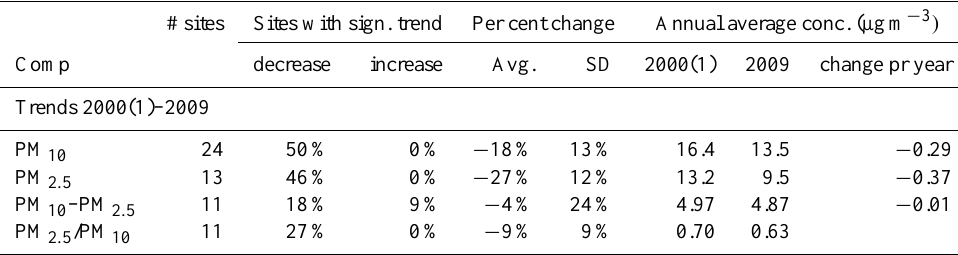
Table 4. Trend analysis of EMEP sites with PM 10 and PM 2 . 5 measurements from 2000-2009 (at some sites time series were initiated in